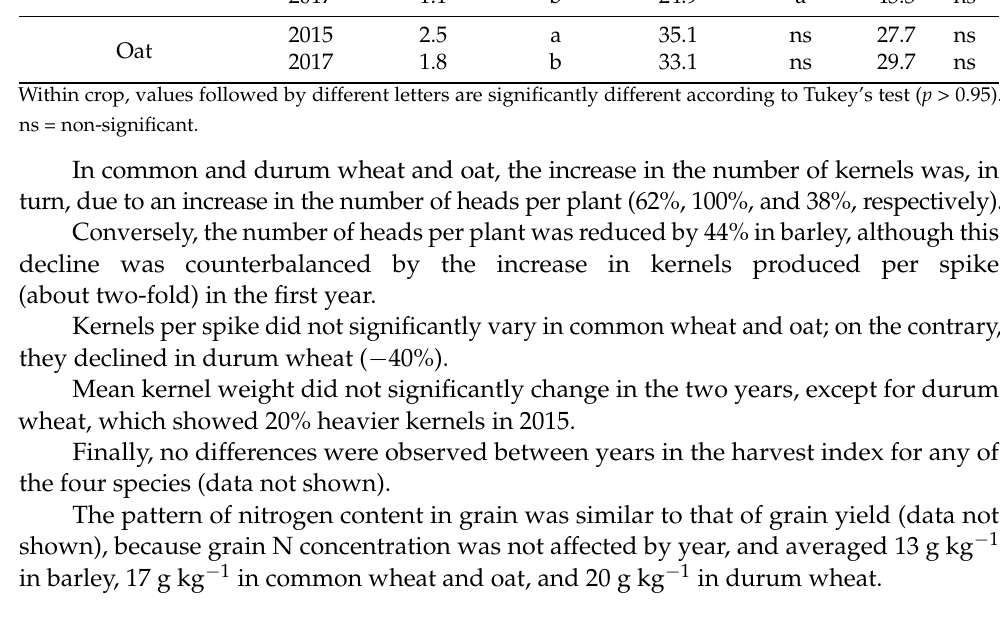
Table 2. Yield components as affected by year treatment in barley, common wheat, durum wheat, and oat. Crop Year Heads Kernels MKW n plant − 1 n head − 1 mg 2015 2.5 Barley Common wheat Durum